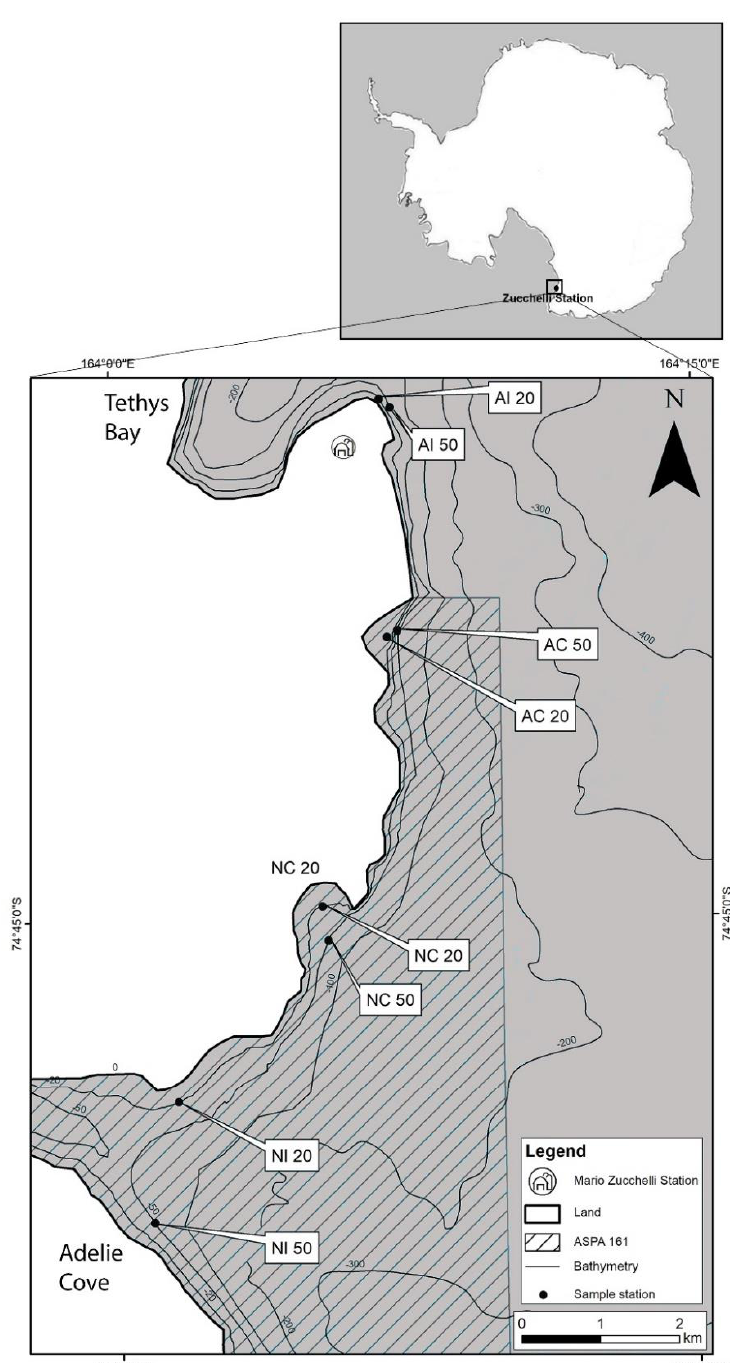
Figure 1. Study area in the Terra Nova Bay area (Ross Sea, Antarctica). Sediments were collected in four sites: anthropically impacted site (AI) and its control (AC); naturally impacted site (NI) and its control (NC). Two stations were also selected in each area, at 20 and 50 m in depth. The limits of the Antarctic Specially Protected Area (ASPA) were also reported on the